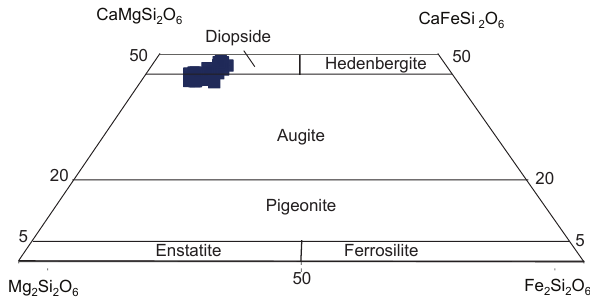
Figure 12. Composition of clinopyroxene (no. 29). All clinopyrox- Fig. 12 ene data plots in the diopside